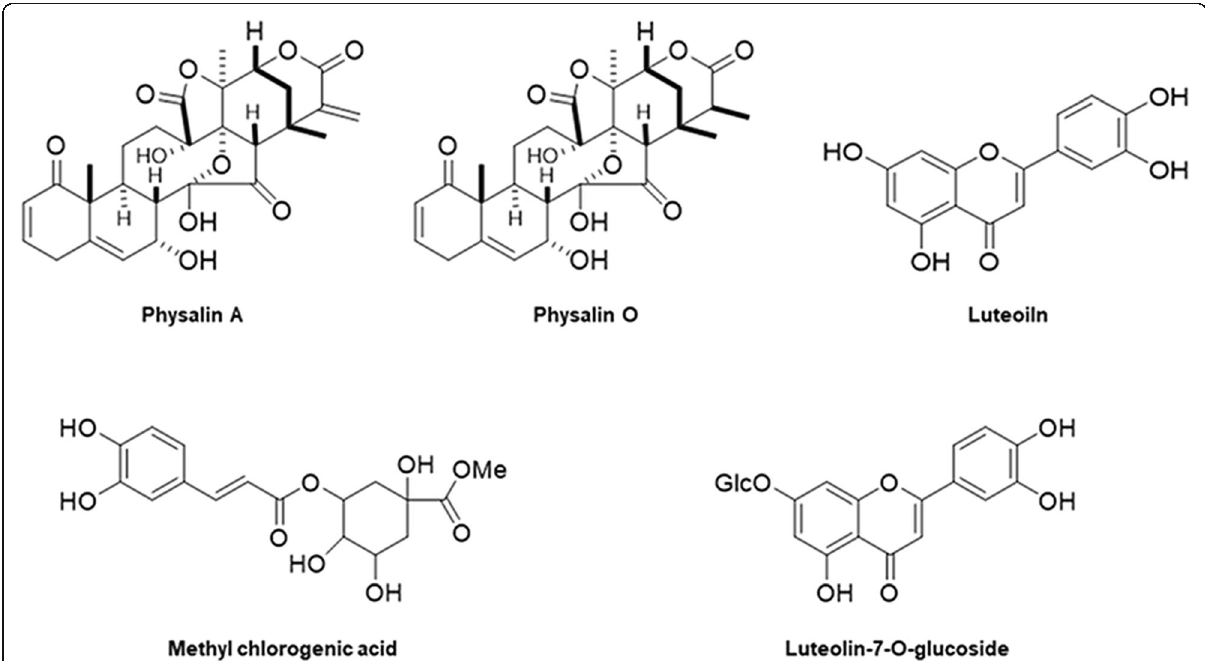
Fig. 2 Structure of physalin A, physalin O, luteolin, methyl chlorogenic acid, and luteolin-7-O-glucoside isolated from P.